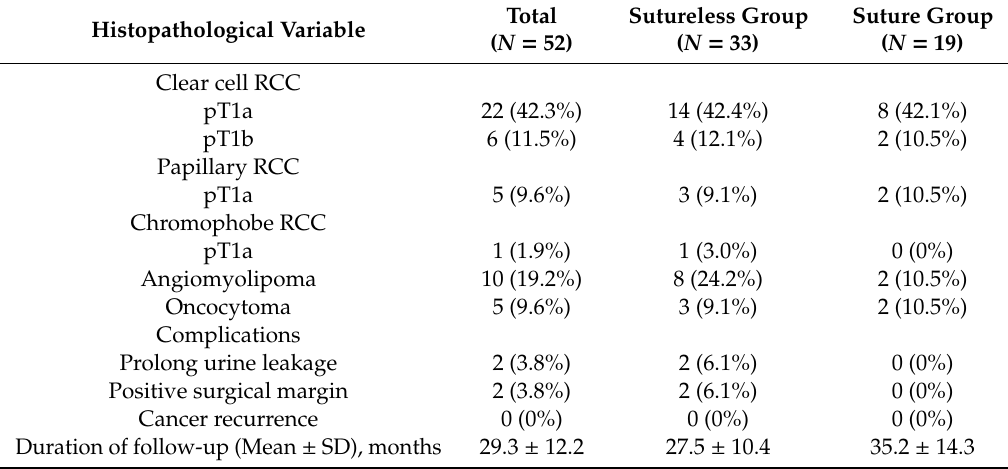
Table 3. Histopathological and follow-up results on patients who underwent